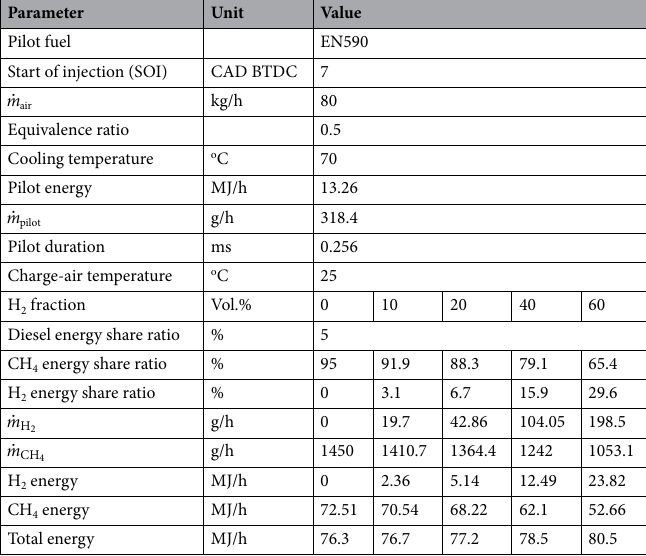
Table 2. Overview of the engine operating conditions.